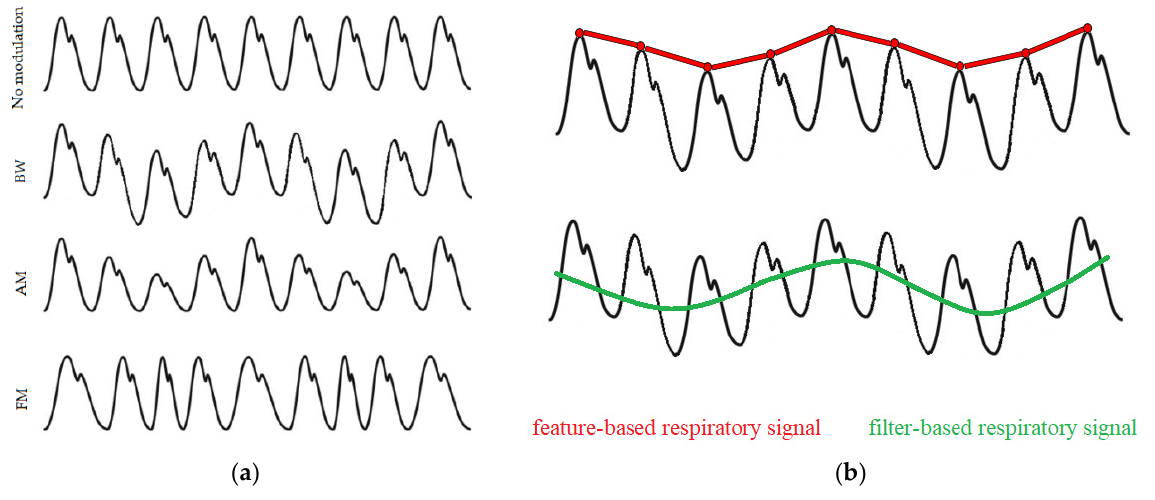
Figure 2. ( a ) PPG signals are subject to three respiratory modulations: baseline wander (BW), amplitude modulation (AM), and frequency modulation (FM); ( b ) Comparison of feature-based (red) and filter-based (green) techniques for extraction of exemplary respiratory signals.